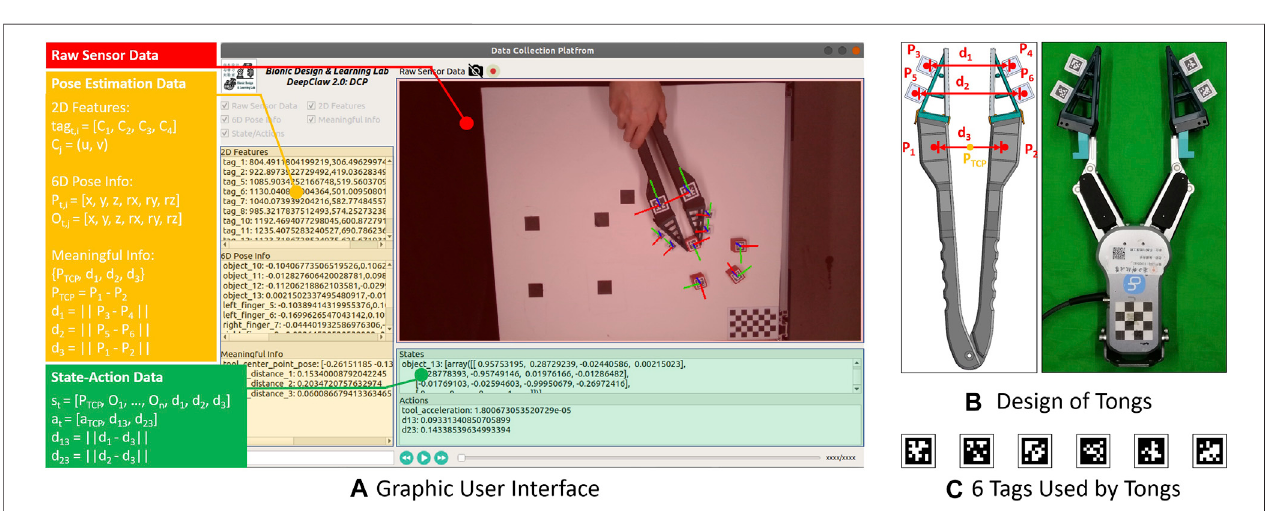
FIGURE 4 | Key components in human manipulation: (A) Shows the rendered graphic user interface in DeepClaw 2.0, consists of real-time RGB data fl ow (highlighted by the red rectangle), low-level features (highlighted by the yellow rectangle), and high-level state-action information (highlighted by the green rectangle). (B) ShowsthesimilaritiesbetweentheassembledtongsandanOnRobotRG6gripper,somekeyparametersarepointed,andin (C) ,sixtagsfromtheAprilTag36h11family used in this paper are shown.